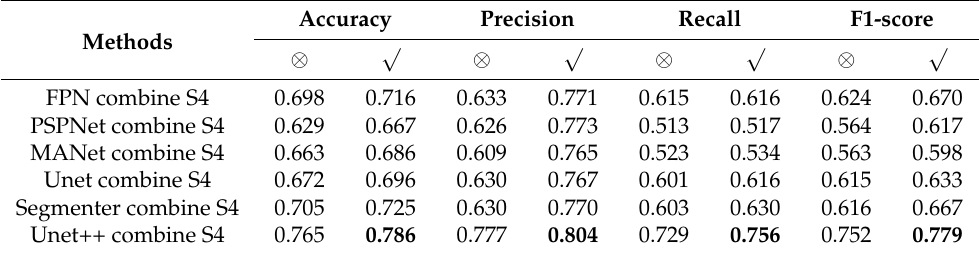
Table 5. Lenke classification results for the compared methods based on segmented results by different deep networks. ⊗ : the post-processing was not used; bold indicates the best